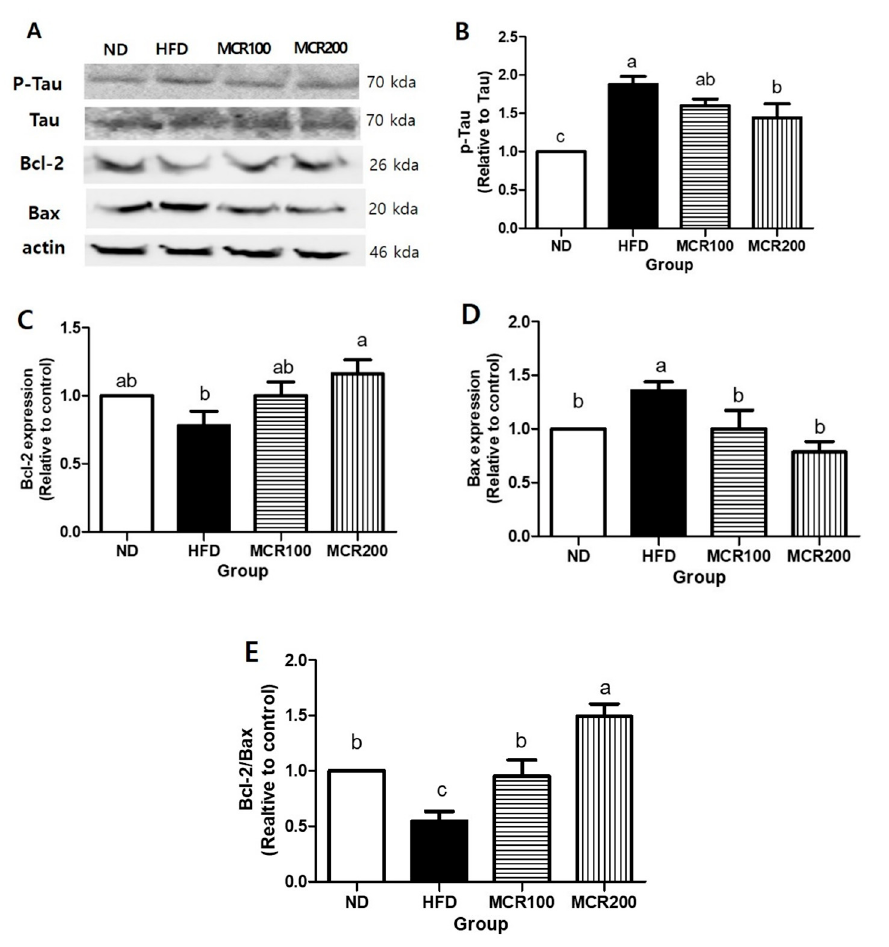
Figure 7. Protective effect of Mori Cortex radicis extract (MCR) on neuronal damage in HFD-induced mice. Mice were fed ND or HFD with or without MCR (100 or 200 mg/kg b.w.) for 14 weeks. Protein expression levels in brain tissues were measured by western blotting. ( A ) Representative western blots of p-Tau, Tau, Bcl-2, and Bax. Cerebral protein expression levels of ( B ) p-Tau, ( C ) Bcl-2, and ( D ) Bax. ( E ) Bcl-2/Bax ratios. Results are presented as means ± SDs ( n = 8). Statistical significance was accepted for p values < 0.05. Small letters indicate significantly different from other groups.